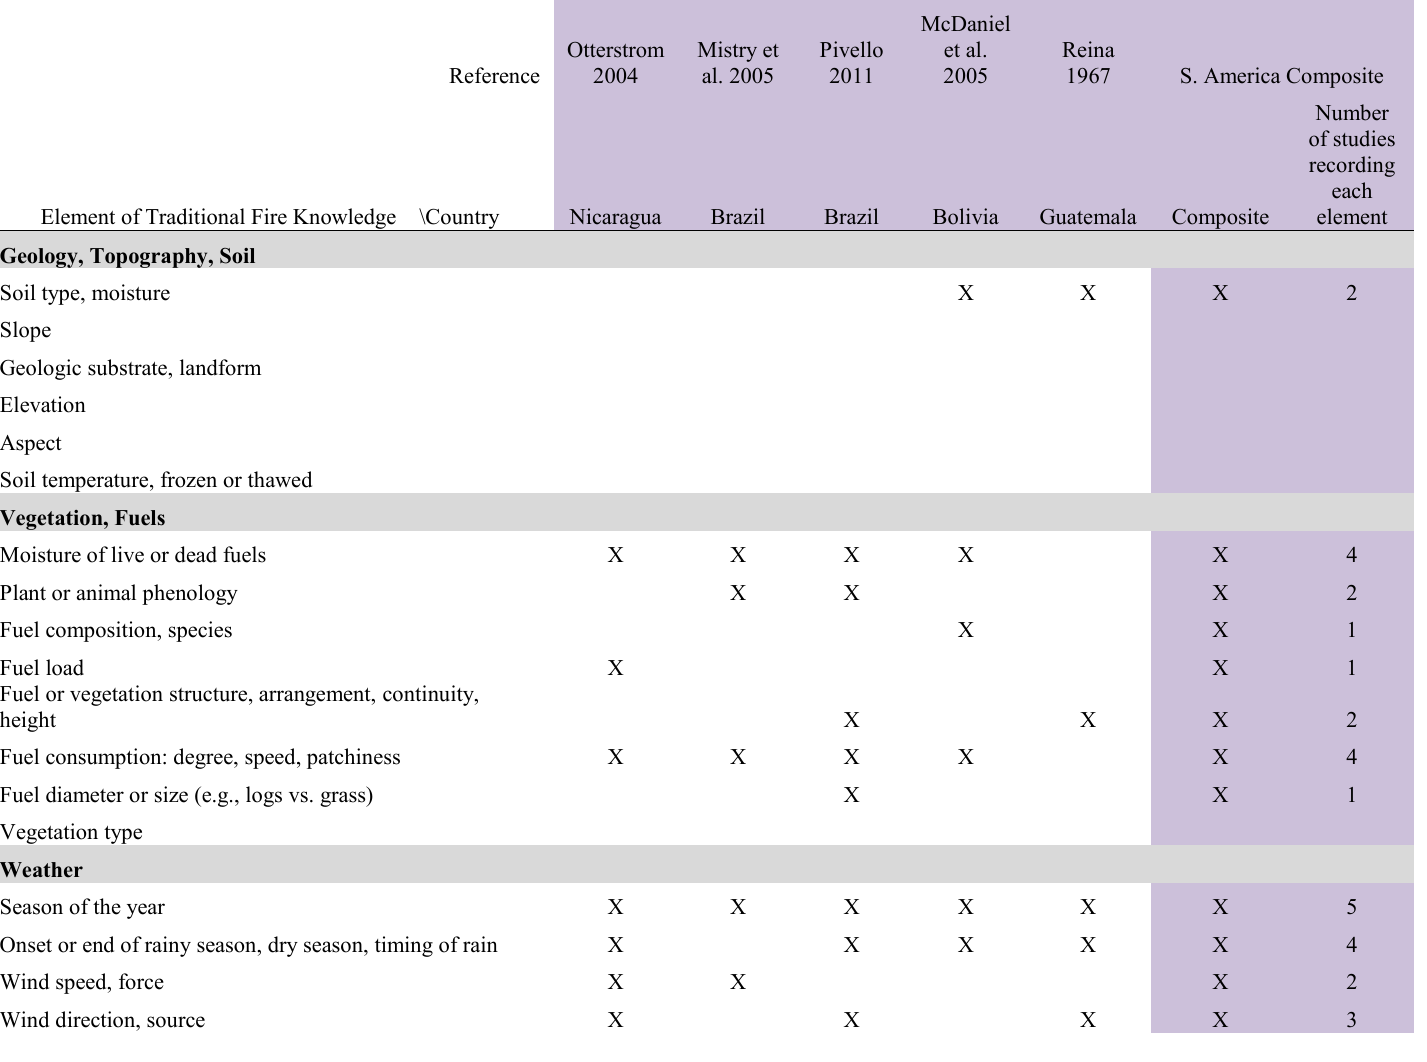
Table A.6. Elements of traditional fire knowledge recorded in studies from South America